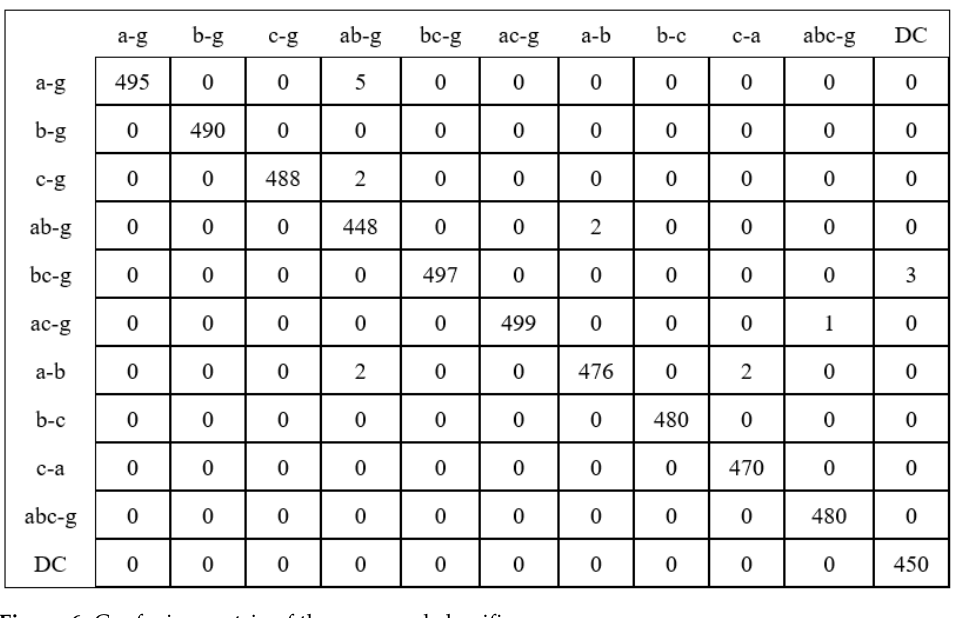
Figure 6. Confusion matrix of the proposed classifier.